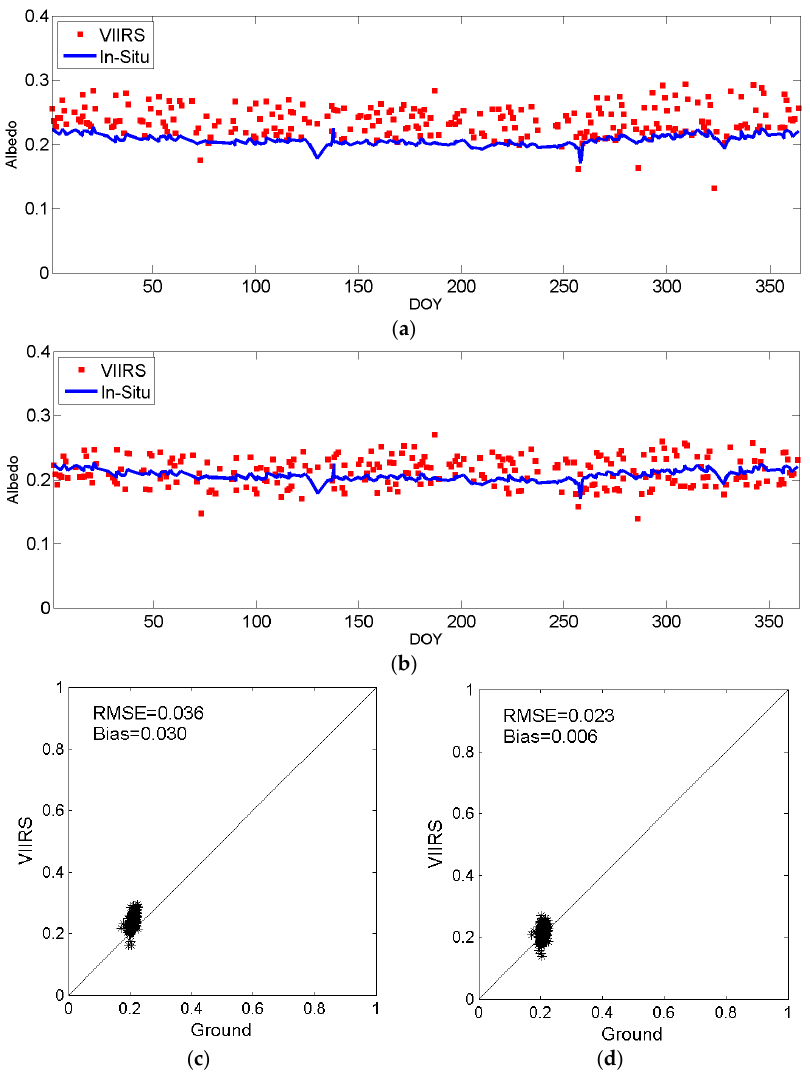
Figure 2. Validation results over a desert site (Rock Desert) for the year 2013. Time series of VIIRS-retrieved albedo using ( a ) current and ( b ) updated desert-specific LUT, respectively. Comparison results between ground truth and VIIRS-retrieved albedo using ( c ) current and ( d ) updated desert specific LUT, respectively.